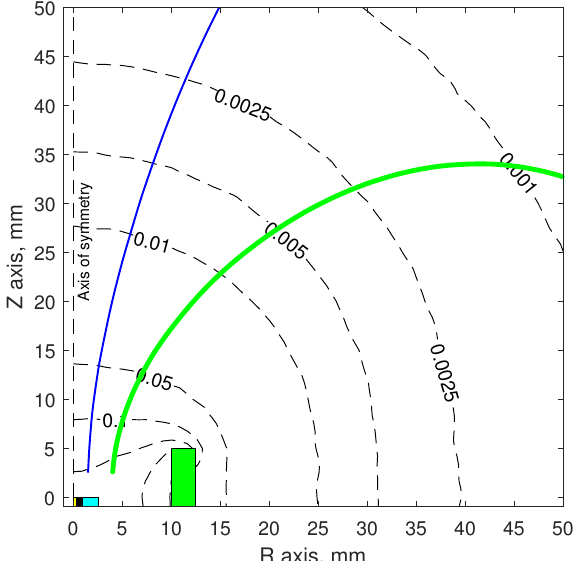
Figure 15. R-Z plot of magnetic field lines representing the nozzle topology for R v ,0 = 1.6 mm (long nozzle) indicated by thin blue line and R v ,0 = 3.8 mm (short nozzle) indicated by thick green line. Magnetic streamlines calculated for B = 0.2 T are indicated by dashed lines. The cathode tip is found at ( R , Z ) = ( 0,0 ) . The cathode (yellow-box), insulator (black-box), anode (Cyan box), and air coil (green-box) positions are also shown here.